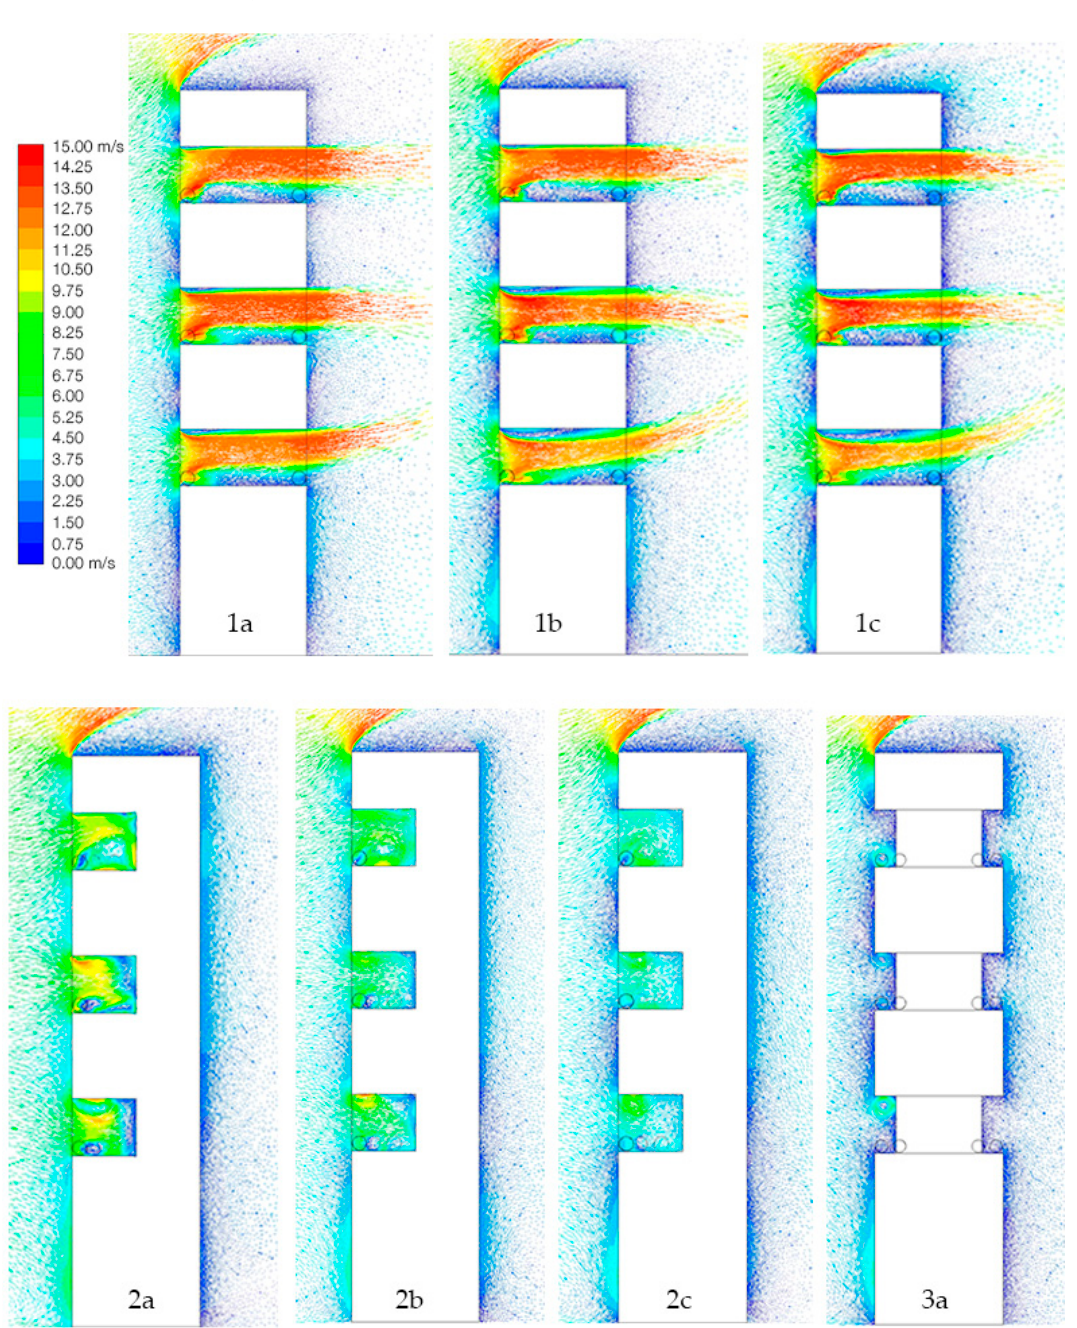
Figure 15. Cross sectional velocity vector through the sky garden centre; (1a) Central sky garden b/B = 0.4, (1b) Central sky garden b/B = 0.6, (1c) Central sky garden b/B = 0.8, (2a) Corner sky garden b/B = 0.4, (2b) Corner sky garden b/B = 0.6, (2c) Corner sky garden b/B = 0.8, (3a) Periphery sky garden a/A = 0.5.